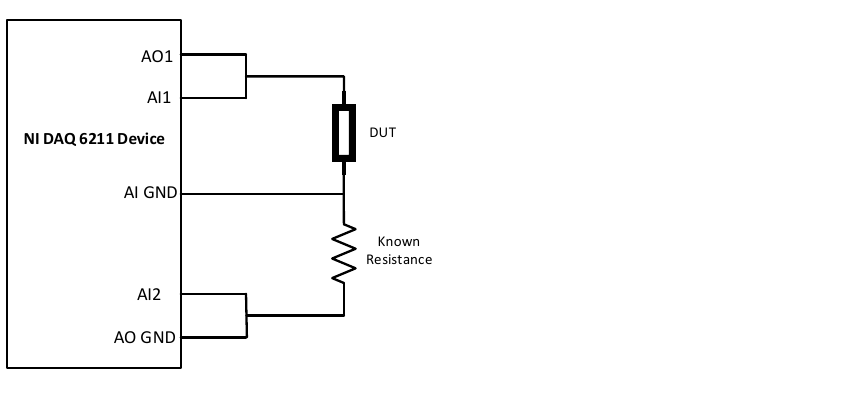
Figure 4. Basic design concept of impedance meter with DAQ device.